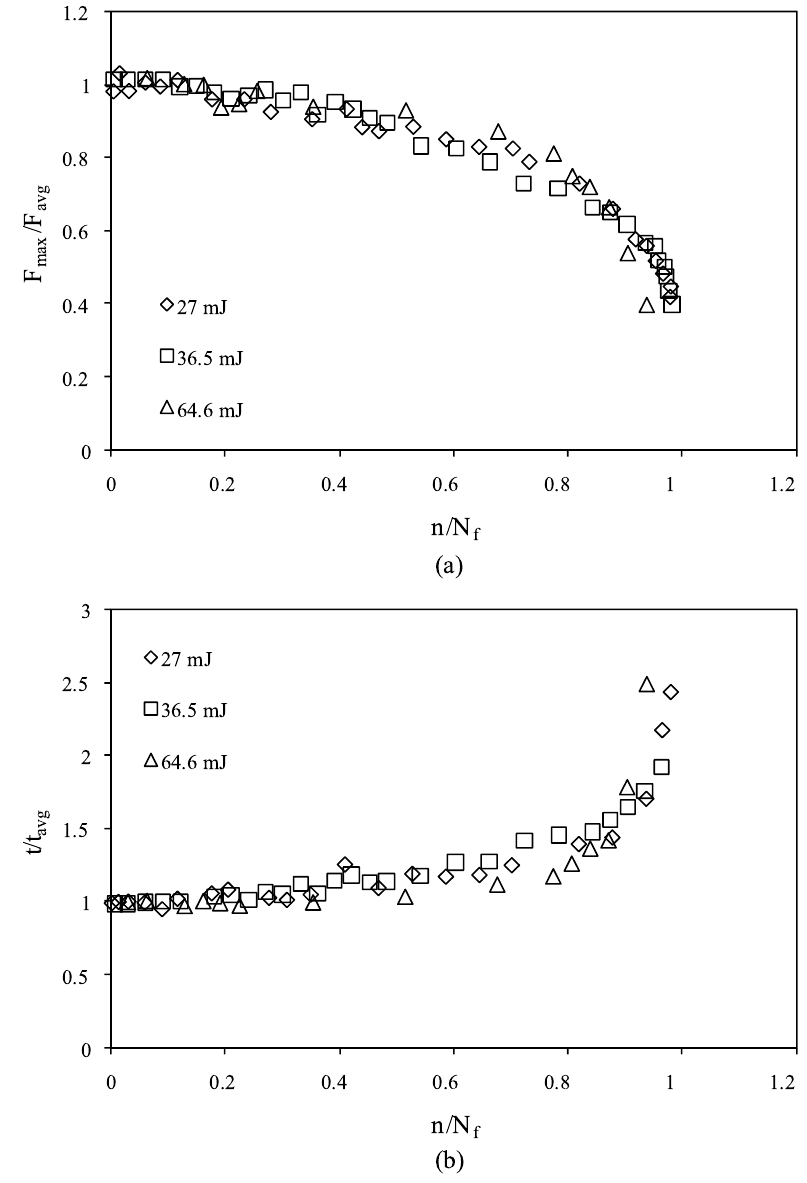
Fig. 4. Effect of normalised number of cycles (n/N f ) and impact energy on (a) normalised maximum force (F max /F avg ) and (b) normalised contact time (t/t avg